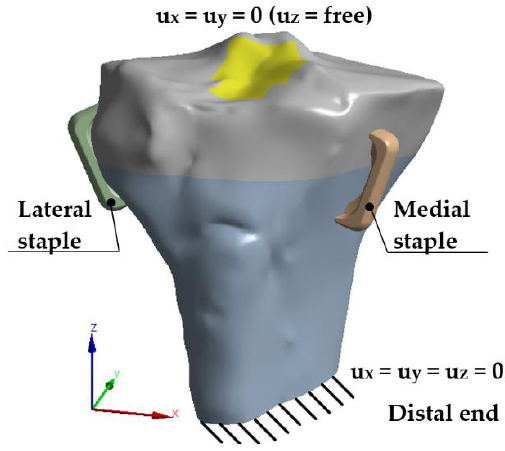
Figure 11. Deformation boundary conditions.